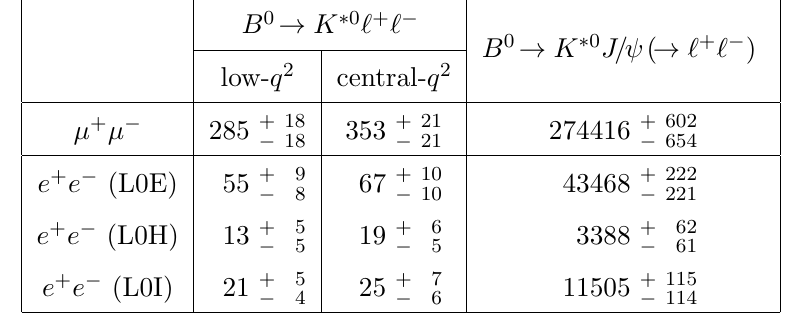
Table 2 . Yields obtained from the mass (cid:12)ts to the muon and electron (in the three trigger cate- gories) channels. The uncertainties are statistical